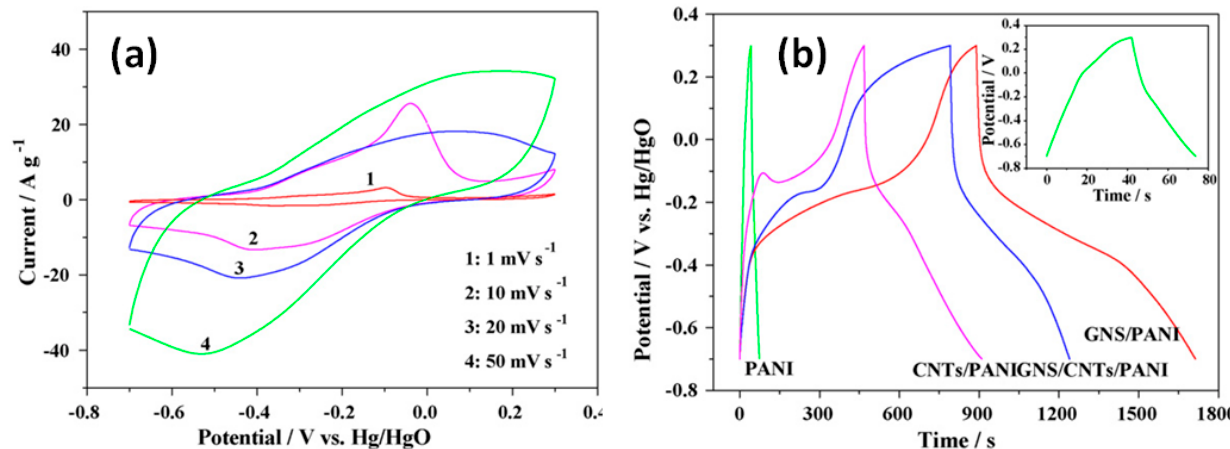
Figure 15. CV curves of rGO-CNT-PANI (GNS/CNTs/PANI) composite at scan rates of 1, 10, 20 and 50 mV/s ( a ) and GCD curves of pure PANI and its composites with CNT (CNTs/PANI), rGO (GNS/PANI) and both of them (GNS/CNTs/PANI) at 2 mA/cm 2 ( b ) (Reproduced with permission of [41]. Copyright Elsevier, 2009).